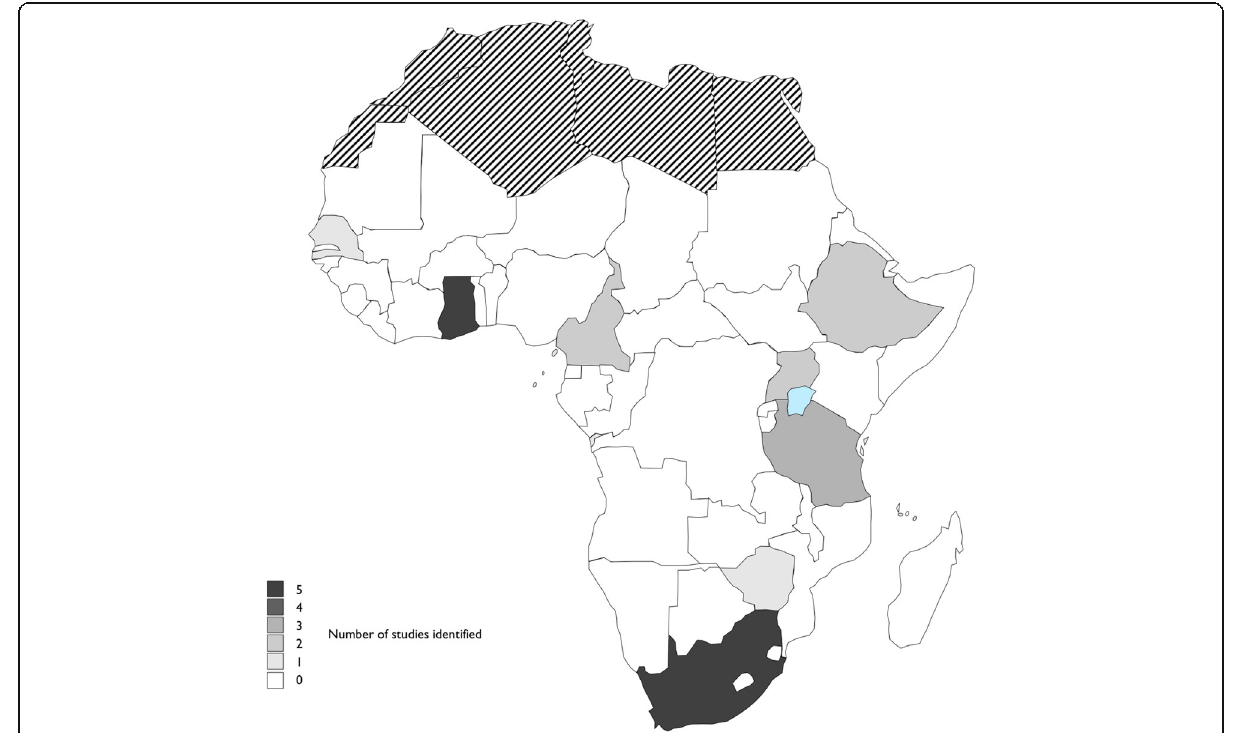
Fig. 2 Map of studies of diabetes experiences in SSA identified in this review (countries in black stripes are not part of the SSA region)